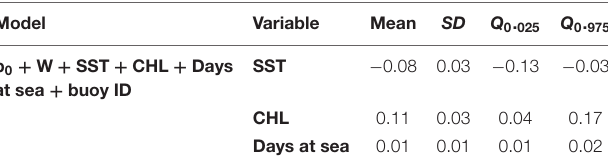
For each variable the mean, standard deviation, and a 95% credible central interval (Q 0 . 025 − Q 0 . 975 ) is provided, containing 95% of the probability under the posterior